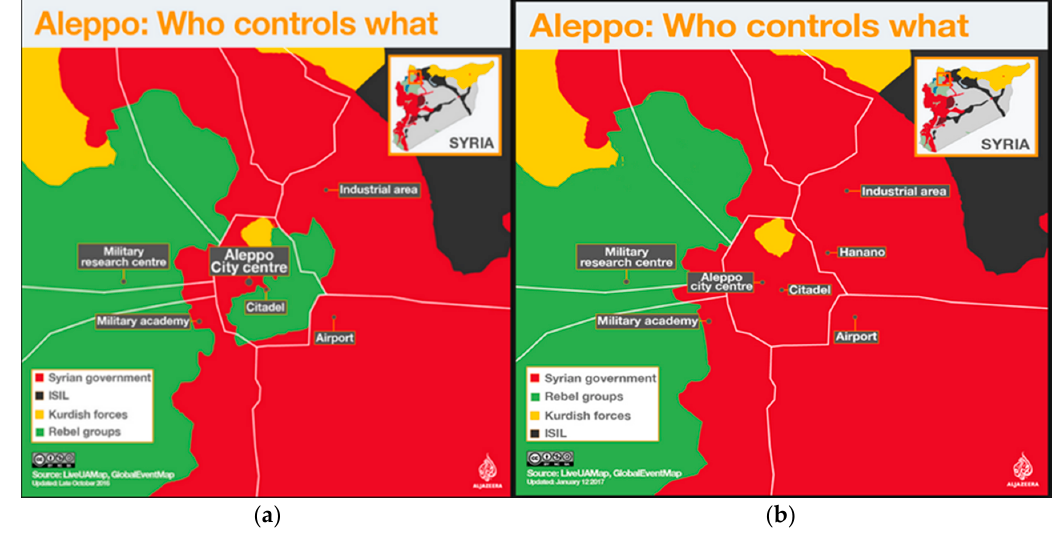
Figure 16. Aleppo Territories. Before Government offensive ( a ) and after Government offensive ( b ). Source: Aljazeera [47].